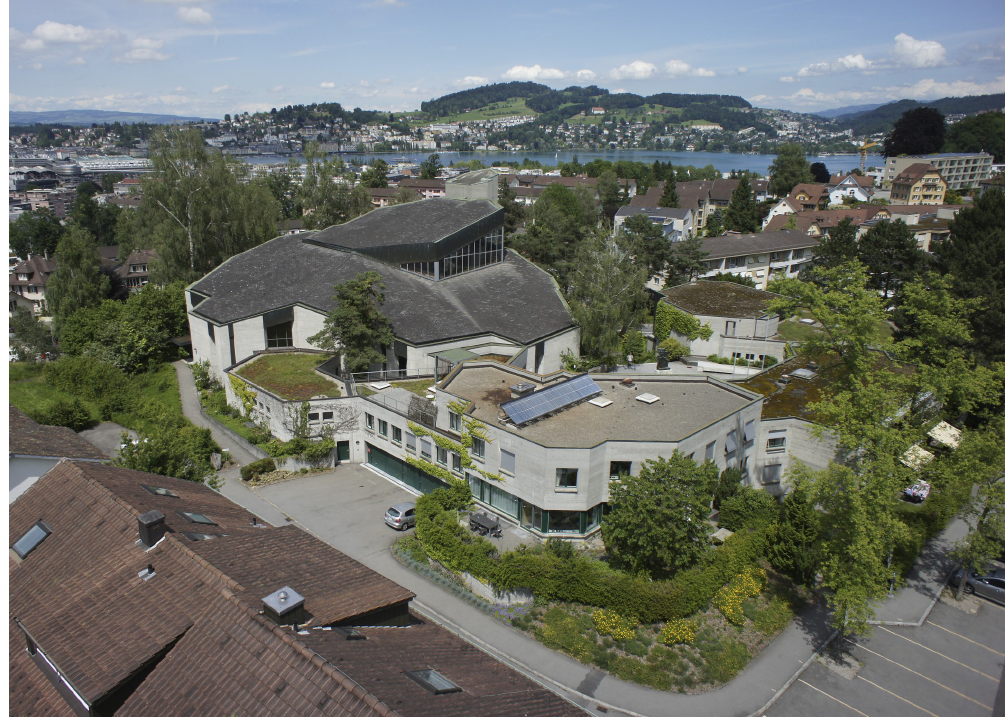
Figure 1. Aerial view of St. Michael’s church with parish in foreground, looking